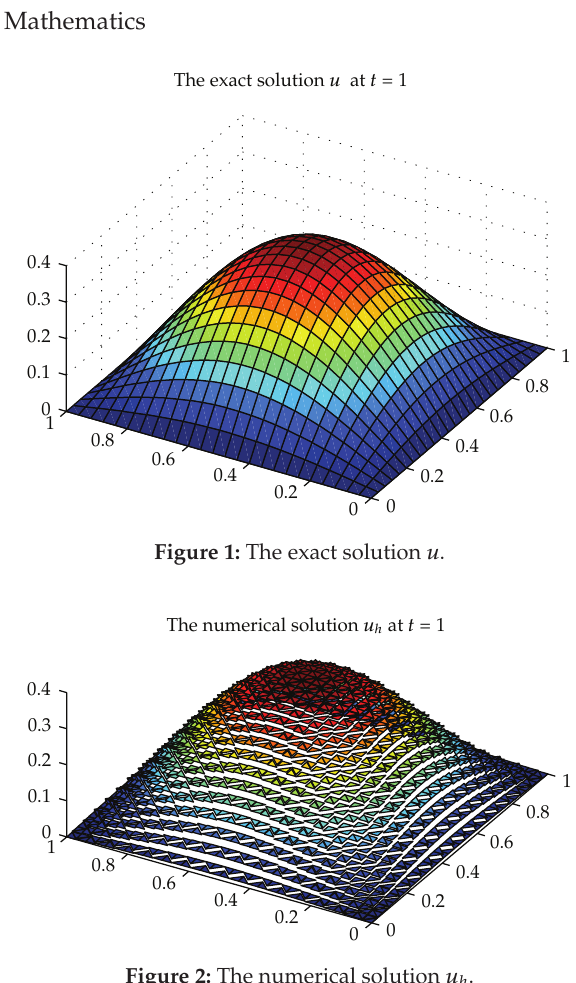
Figure 2: The numerical solution u h